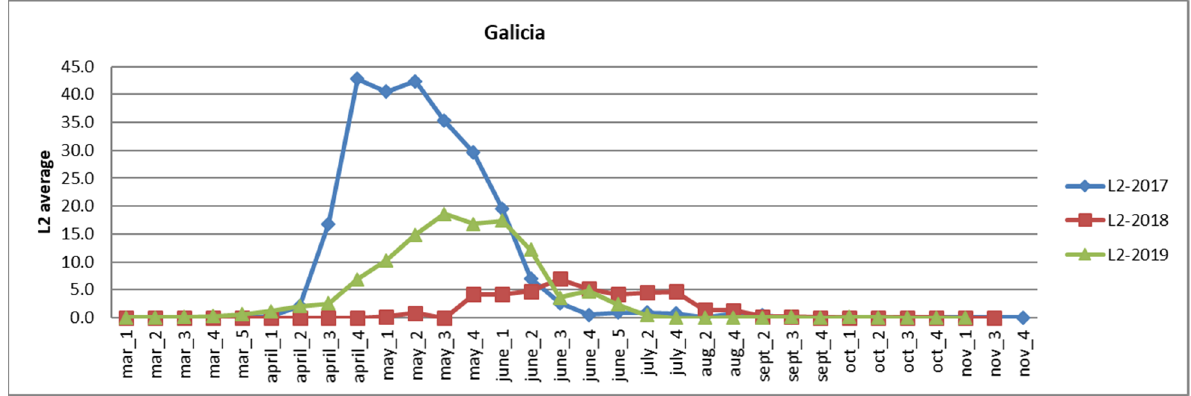
Figure 9. Evolution of the average number of larvae in stage L2, according to the week of the survey month.